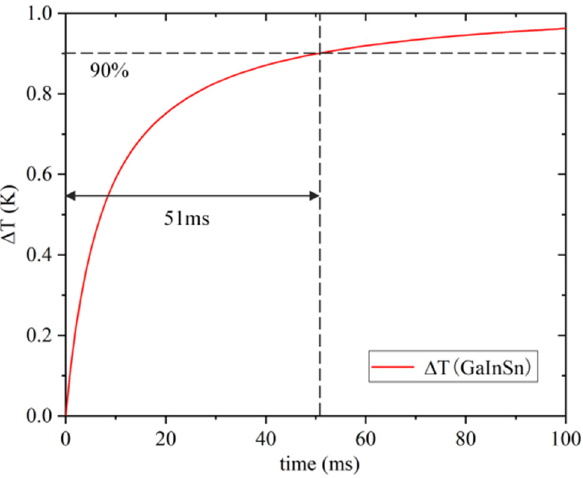
Figure 6. Relationship between temperature change and response time.